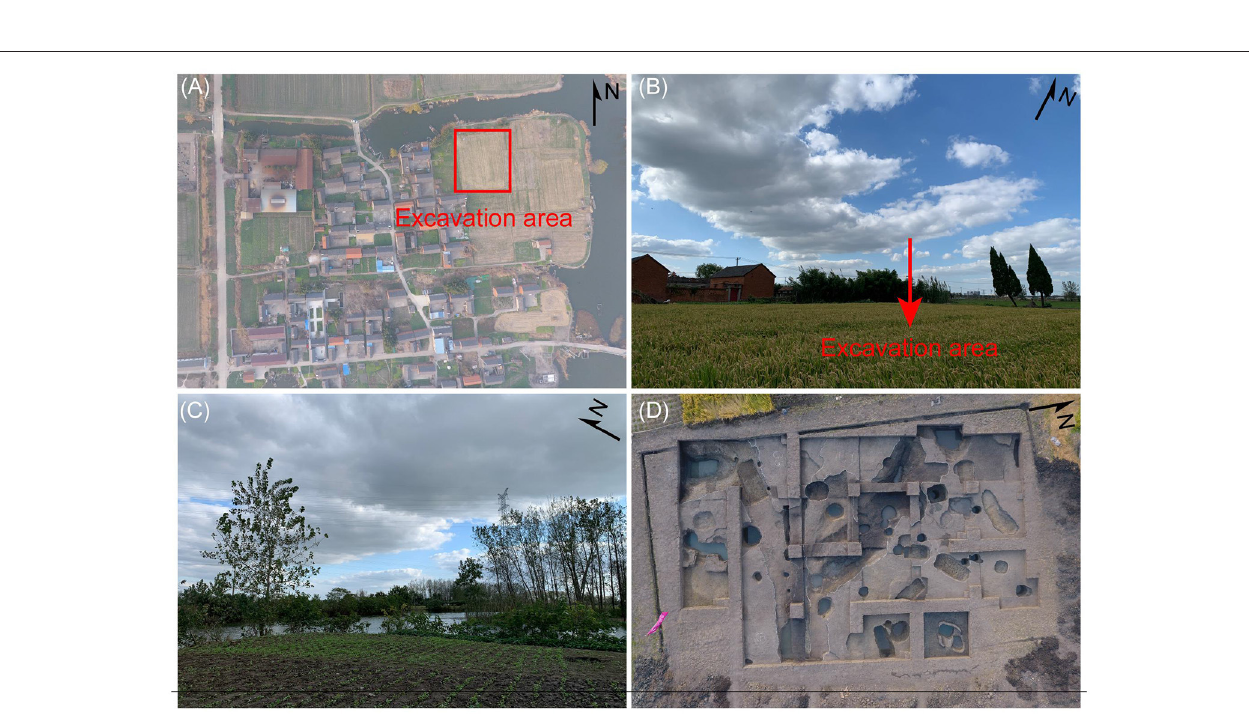
FIGURE 2 | The landscapes of Datongpu site. (A) Aerial view of the excavation area of Datongpu site; (B,C) Geomorphic map of Datongpu site before excavation; (D) Excavation plan of datongpu site.